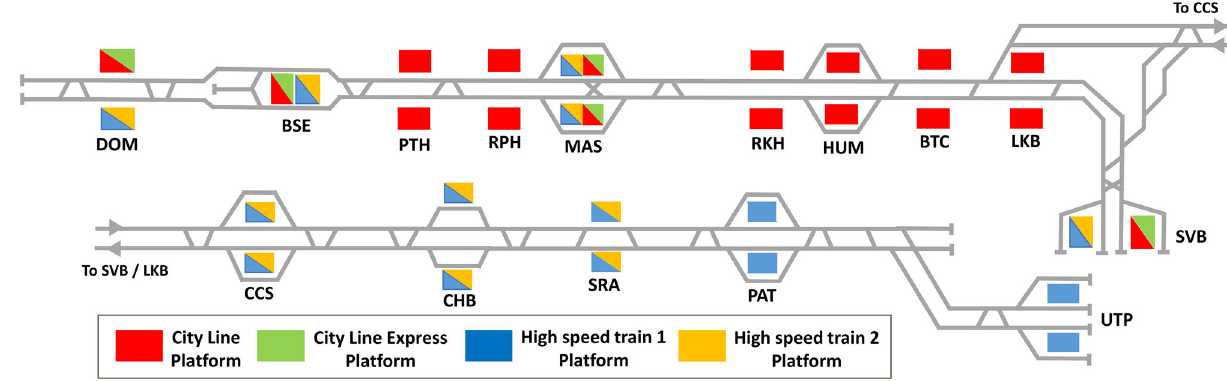
Fig. 1 Track outline of three airport project